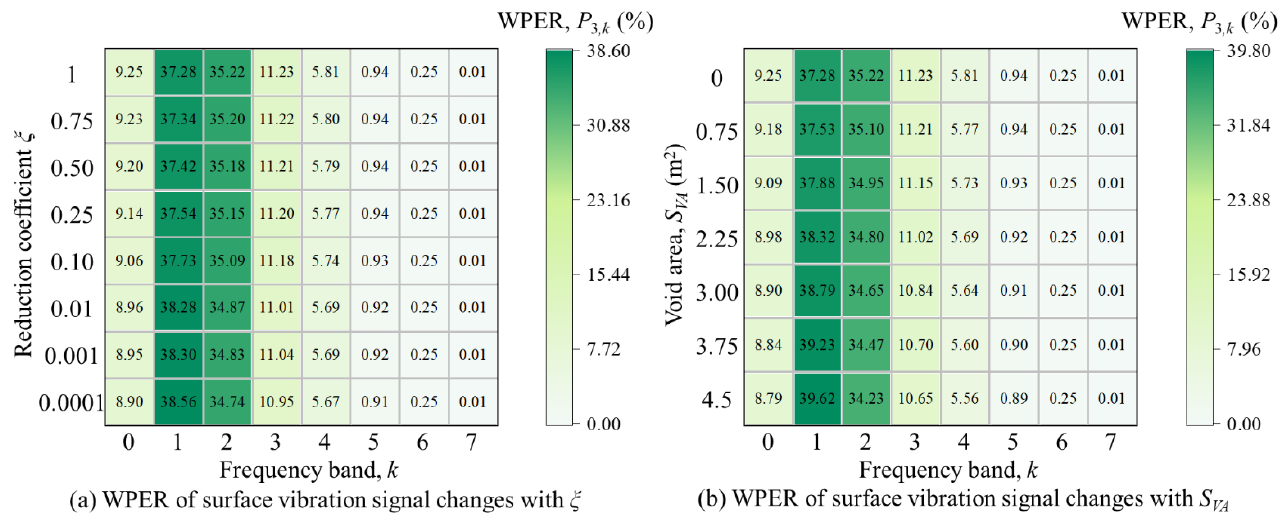
Figure 13. Energy distribution characteristics of vibration signal at monitor point 1.